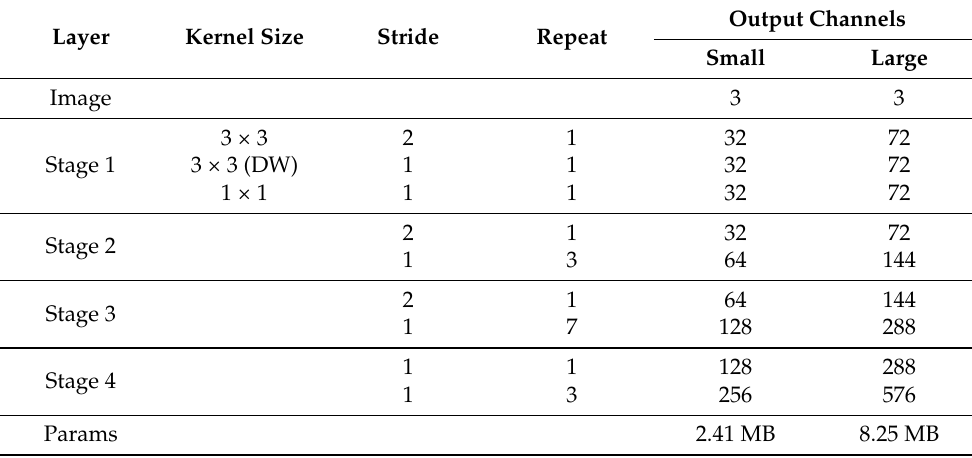
Table 1. The detailed parameter settings of the encoder. The large and small models had different output channels and model